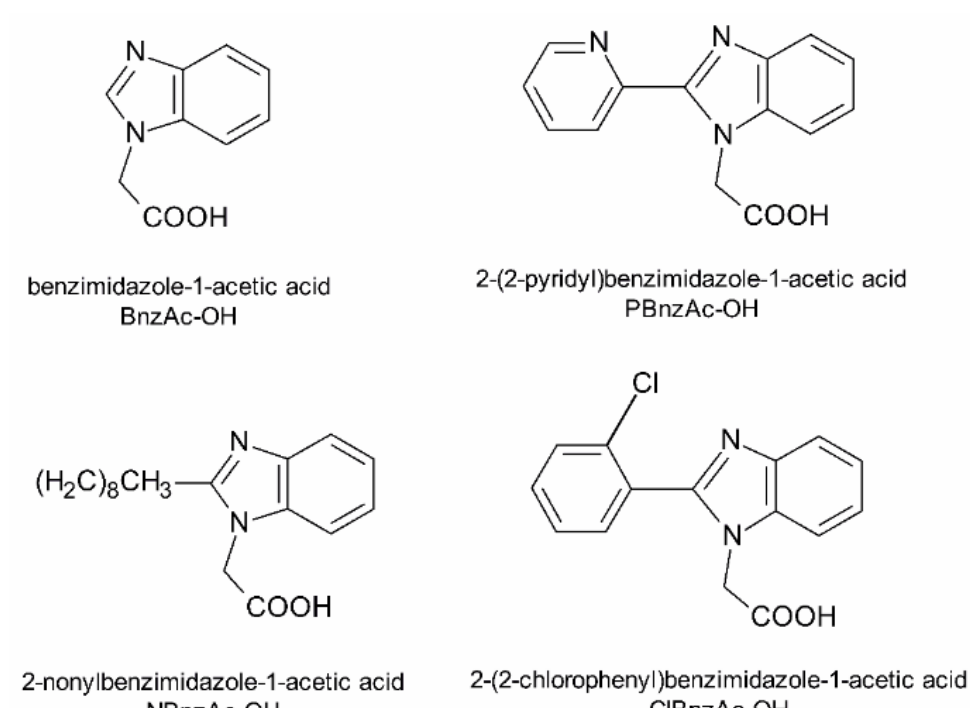
Figure 1. Structures of synthesized benzimidazole derivatives attached to TP10 sequence.